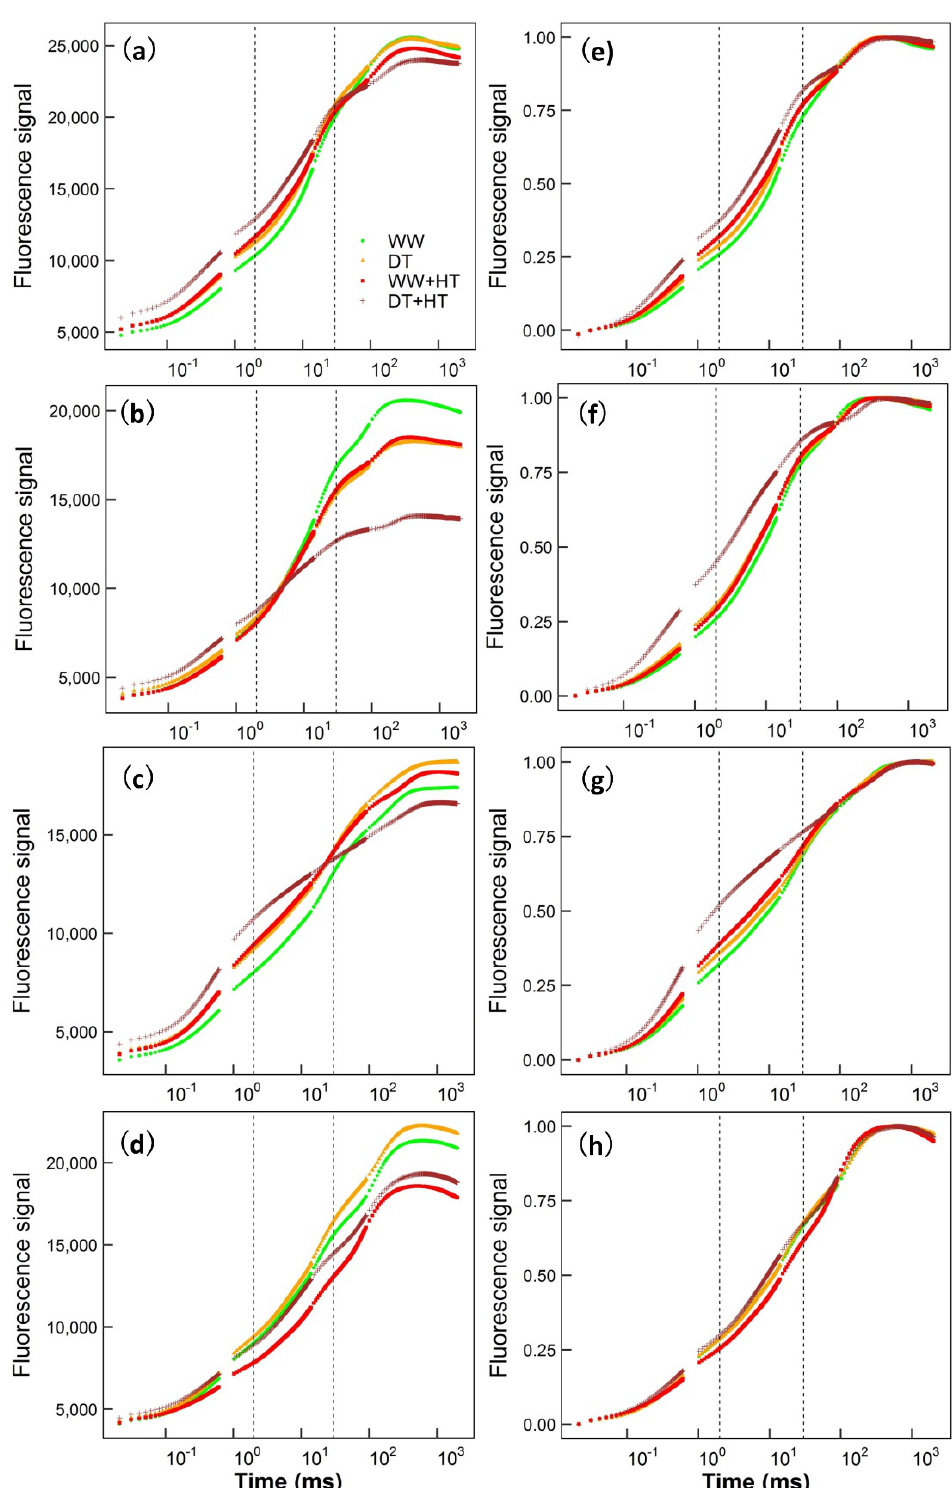
Figure 1. Chlorophyll fluorescence OJIP kinetic curves of four treatments in four species: wheat ( a , e ), sorghum ( b , f ), F. chinensis ( c , g ) and R. sinica ( d , h ). Panels ( a – d ) show the original fluorescence signal values and Panels ( e – h ) shows the normalized fluorescence signal values. The first vertical dashed line represents the J phase, which is at 2 ms; the second vertical dashed line represents the I phase, which is at 30 ms. “WW” and “DT” are the average of the data from the day before imposing heat stress on well-watered (WW) and droughted (DT) plants, respectively. “WW + HT” and “DT + HT” are the average of the data on the second day of heat stress in WW and DT plants, respectively.